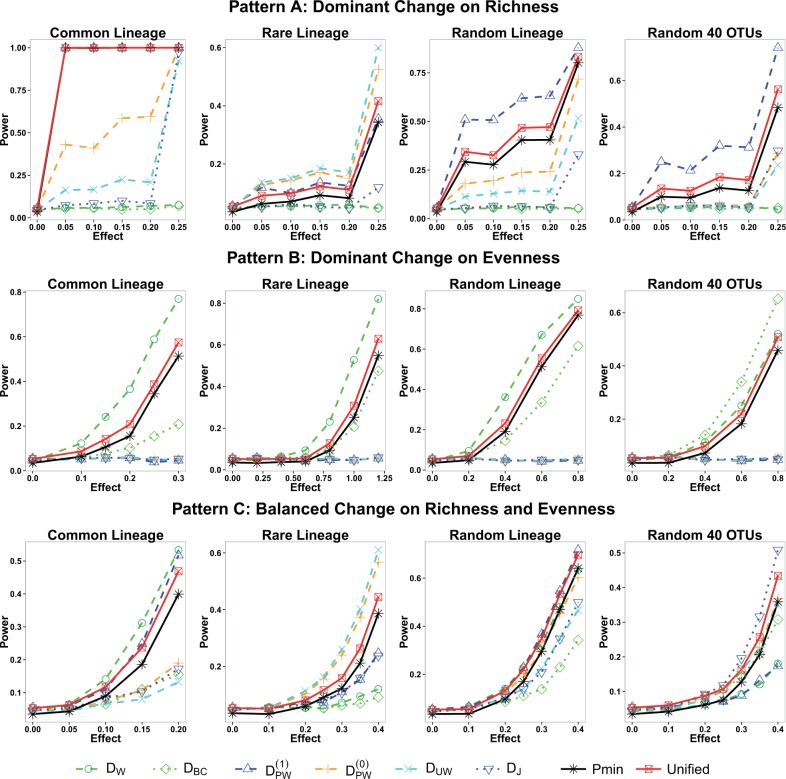
Power of abundance distances, presence–absence distances, Bonferroni-adjusted test and PERMANOVA-S unified test under various differentiation patterns. Each curve is created by varying the degree of differentiation between two groups, with 10 samples per group